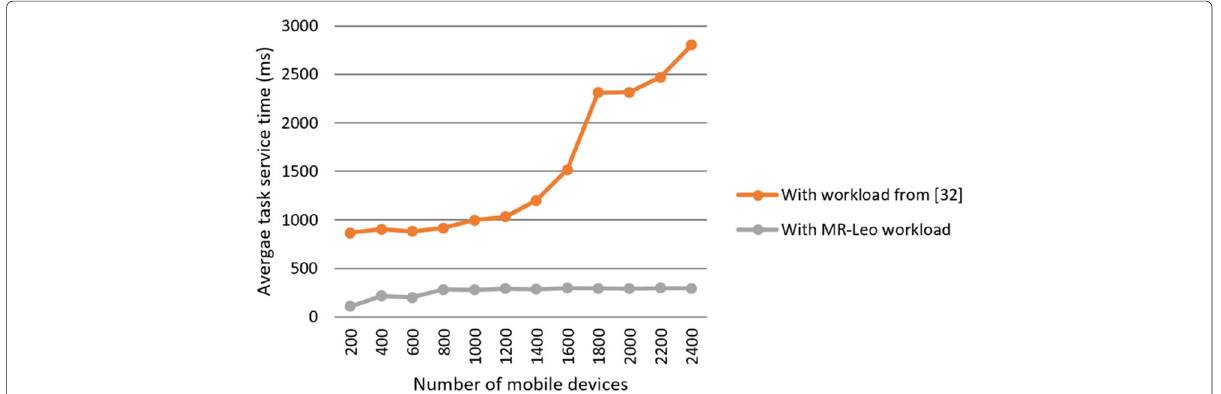
Fig. 19 Performance evaluation of the fuzzy algorithm proposed in [32] when using the two compared MR workload